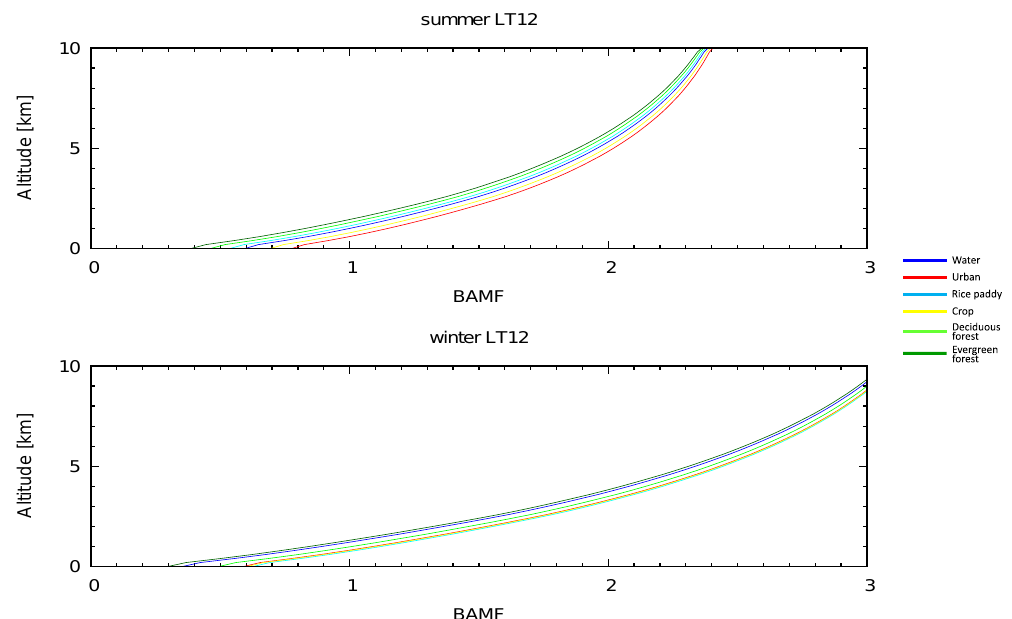
Figure 9. Tropospheric NO 2 BAMF at 12:00 local time (LT) in summer (left) and winter (right) using BRDF surface. The colors indicate land cover types: water (blue), urban (red), rice paddy (light blue), crop (yellow), deciduous forest (light green), and evergreen forest (green). An aerosol optical depth (AOD) of 0.2 is assumed.